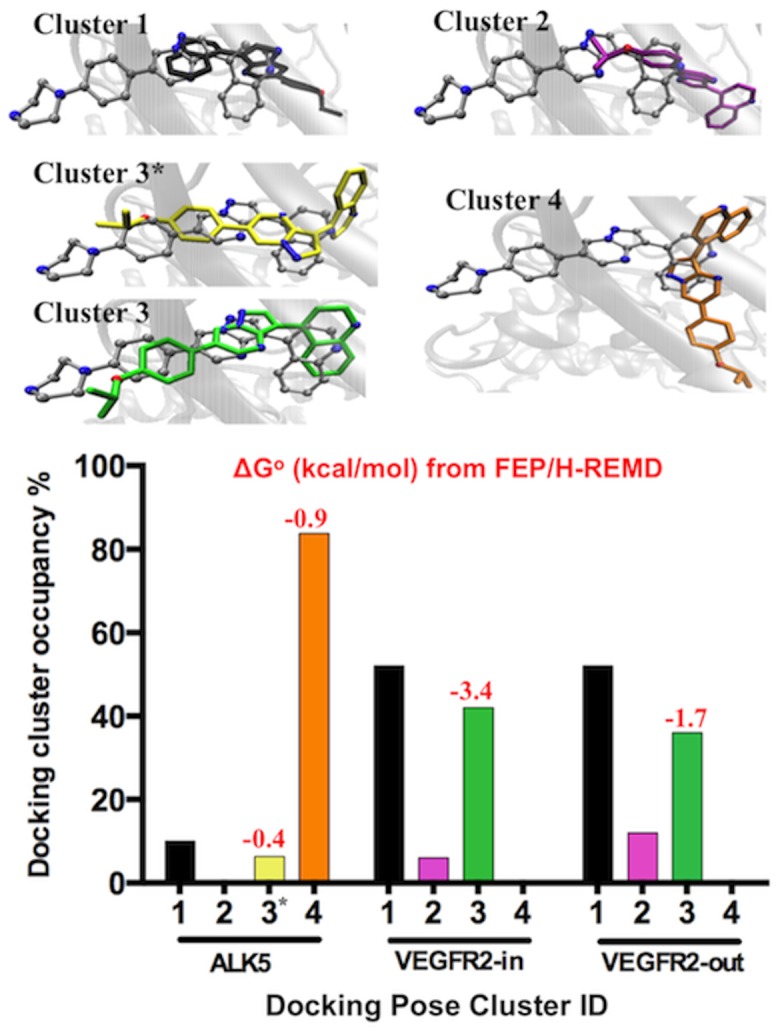
Clustered DMH1 docking poses in ALK5, VEGFR2-in, and VEGFR2-out proteins.Each docking cluster represents a group of ligand poses with ligand RMSD < 2 Å. Top: Representative docking poses in each cluster superimposed on LDN193189 (gray) in the ALK2 x-ray structure. Bottom: The occupancy of each docking cluster, with FEP/H-REMD binding free energy shown in red on top of each histogram (positive values are not shown here). The color of the ligand-binding pose corresponds to those in the bar graphs in the bottom.